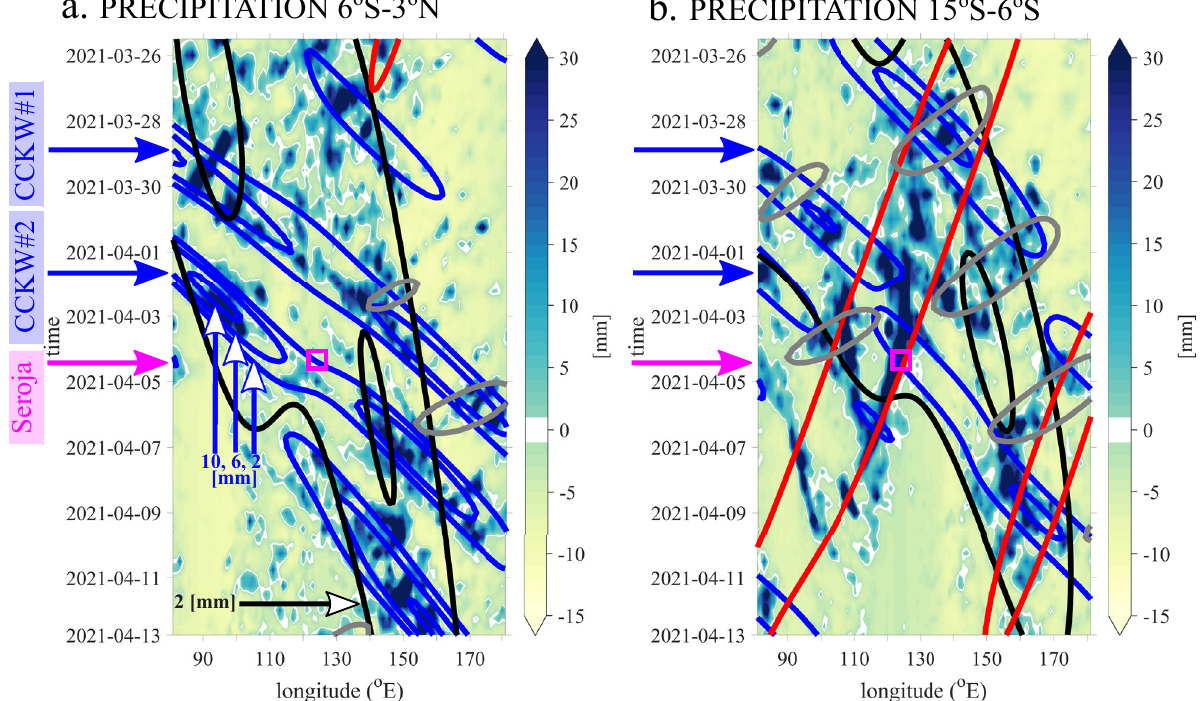
Fig. 4 | Time-longitude Hovmöller diagrams based on GPM precipitation data. a 6 hourly accumulated GPM precipitation anomalies [mm] averaged between 6°S and 3°N (color shading). Line contours show amplitudes of selected equatorial modes that have been wavenumber-frequency fi ltered: Convectively Coupled Kelvin Wave (blue lines), Convectively Coupled Equatorial Rossby Waves (red